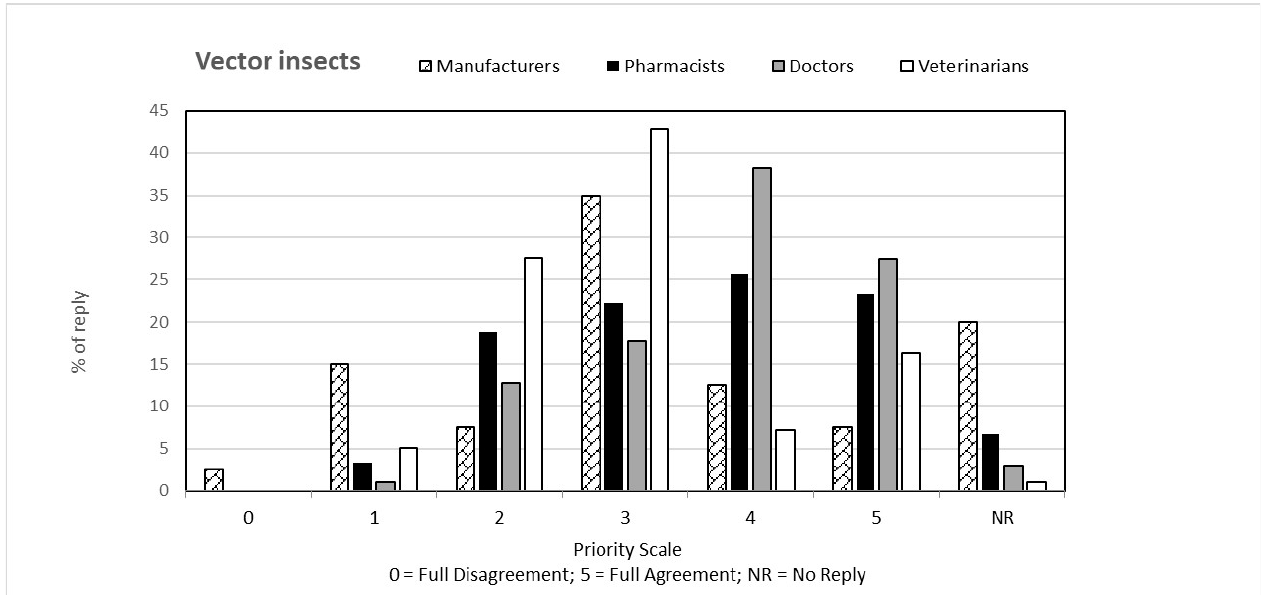
Figure 3. Percentage of answers “VECTOR INSECTS” to the question “Global Environmental Changes manifest themselves with ....” given by the four interviewed categories. The tables also include the percentage of “no reply” (NR) responses.